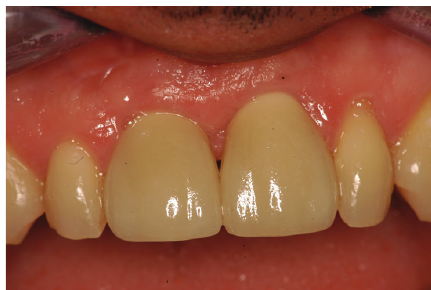
Figure 7: Clinical control after 1 year from the surgery.